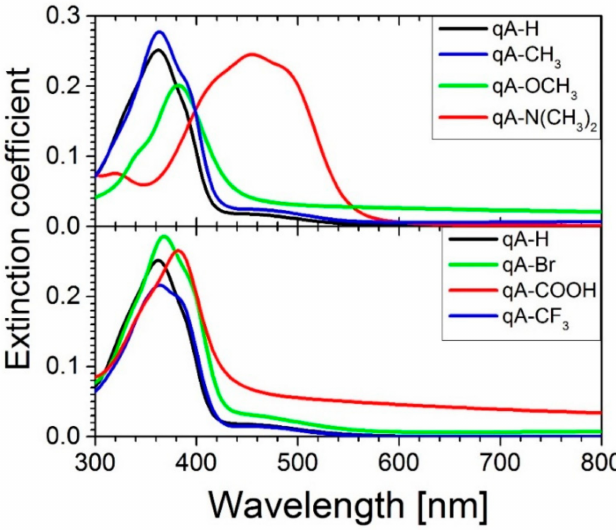
Figure 4. The extinction coe ffi cient versus wavelength for quinoline azo-dye polymers with various electron donating and electron withdrawing